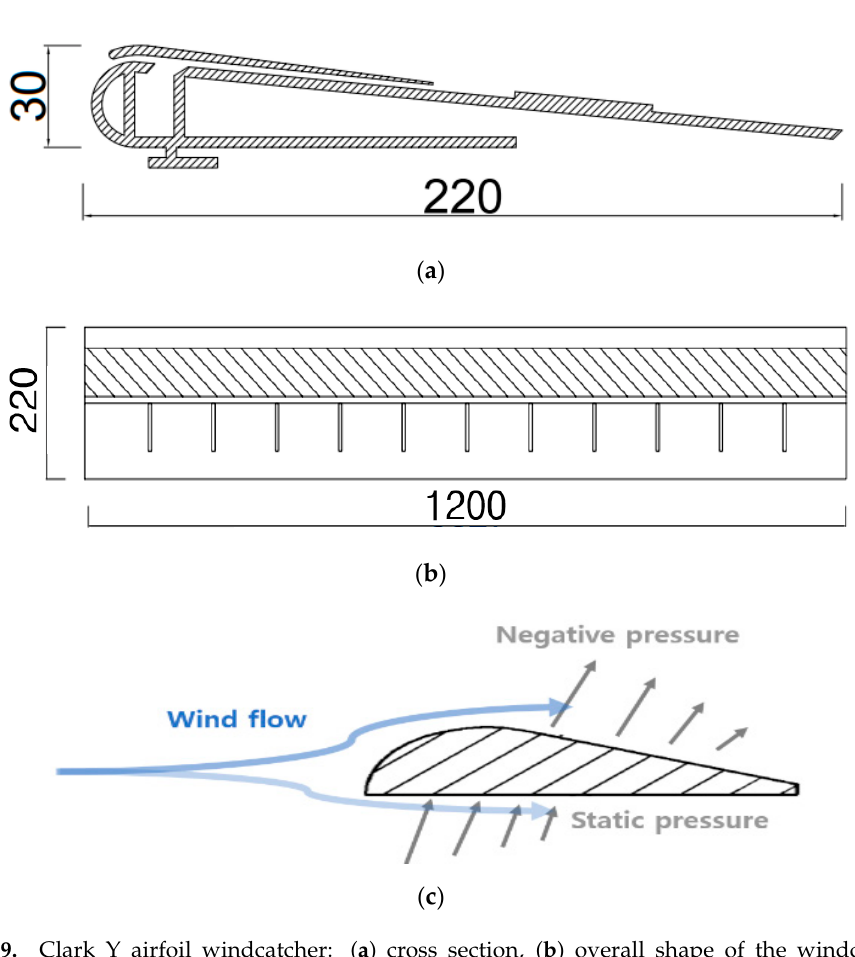
Figure 9. Clark Y airfoil windcatcher: ( a ) cross section, ( b ) overall shape of the windcatcher, and ( c ) pressure distribution.